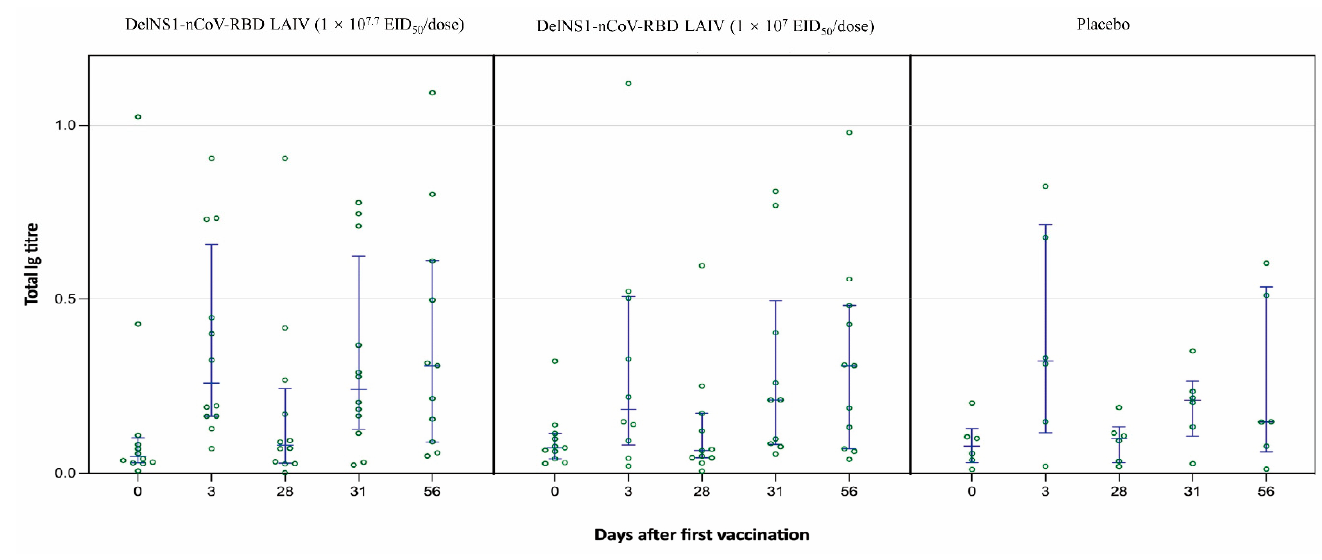
Figure 5. Total saliva Ig titre over time. Saliva samples were collected at baseline (day 0) and at 3, 28, 31, and 56 days after the first vaccination. After being treated with 1% Triton-100 for 30 min, saliva was diluted 2 folds with PBS. Biotinylated recombinant SARS-CoV-2 RBD was added into the 96-well plate coated with avidin for a 30 min-incubation. Then, treated saliva samples were added into the wells. After 1 h, the plate was incubated with horseradish peroxidase (HRP) conjugated goat anti-human IgG, IgM, and IgA antibody. Finally, the optical density (OD) was read at 450 and 620 nm. One-way ANOVA was used to compare the mucosal Ig response in the three